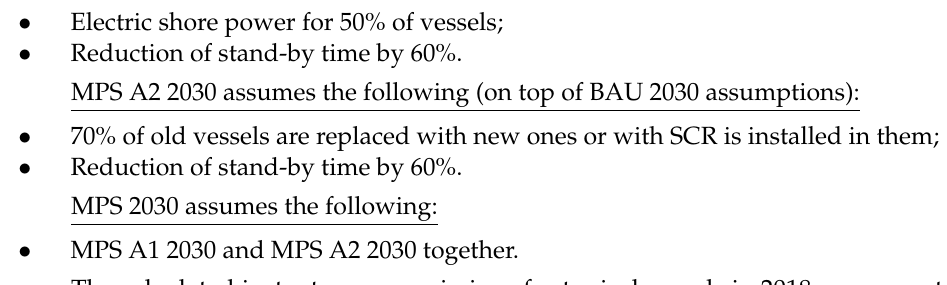
The calculated instantaneous emissions for typical vessels in 2018 are presented in Table A8 with units of gram pollutant per second (g/s). The total yearly vessel emissions calculated for the different scenarios (as described above) are shown in Tables A9–A26 and in Figure A2 with units of ton pollutant per year (ton/year), and also detailed in [111]. Table A8. Instantaneous emissions from vessels (2018 situation).